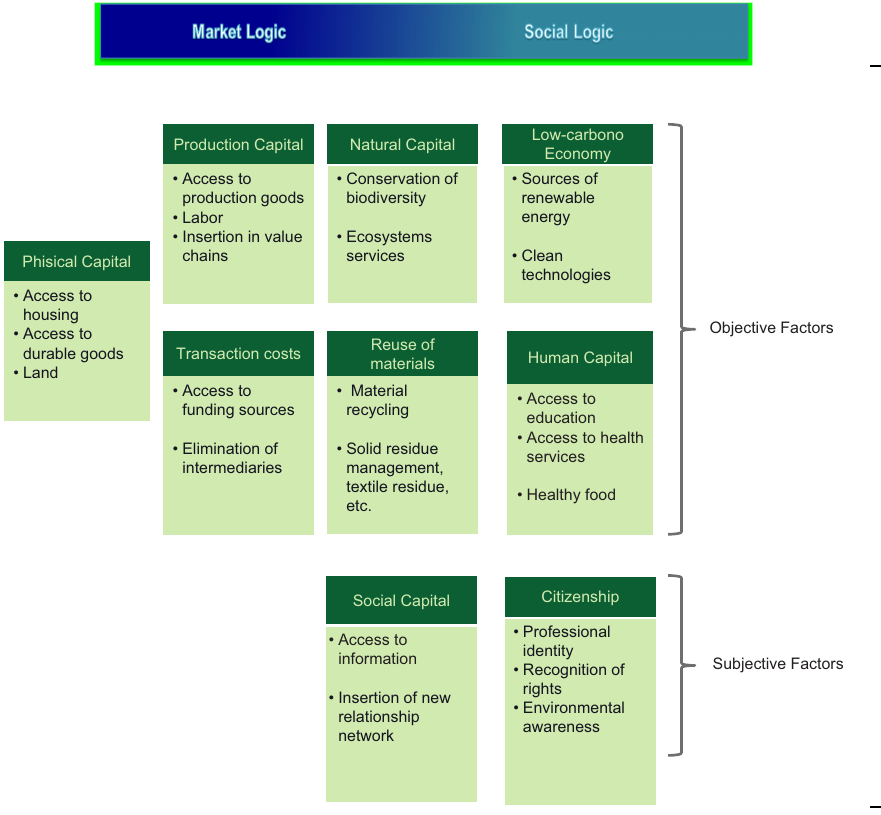
Figure 1. Continuum – positioning of social businesses